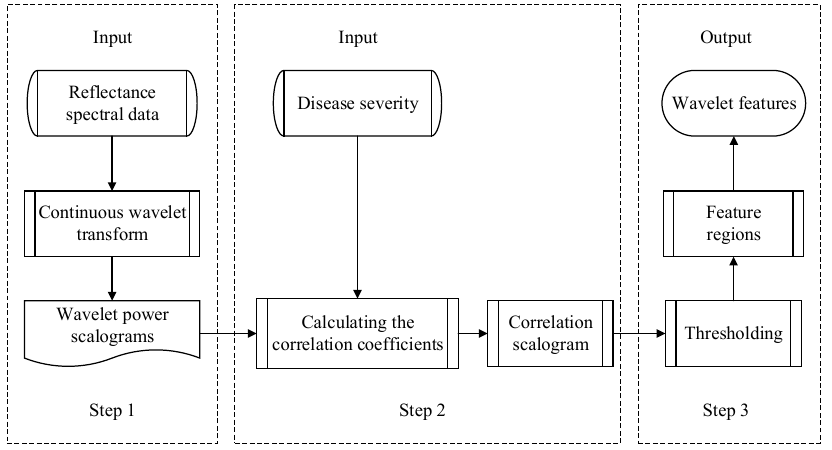
Figure 3. Flowchart of wavelet feature extraction using continuous wavelet analysis. Step 1: Calculation of the wavelet power